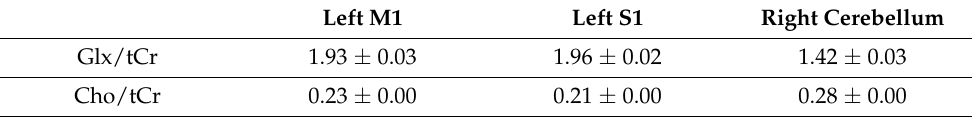
Table 3. Mean neurometabolite concentrations in M1, S1, and the